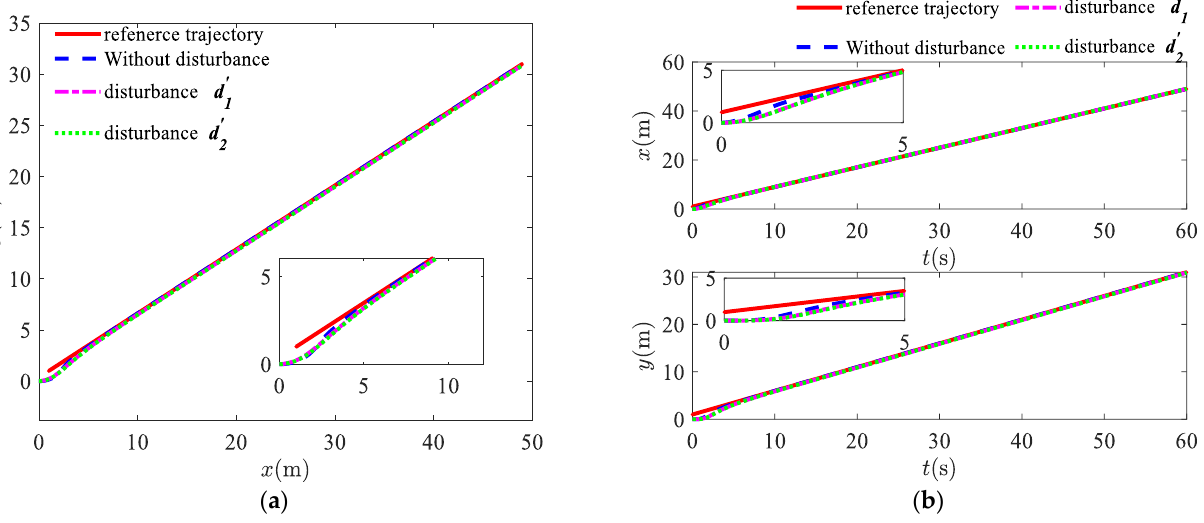
Figure 2. Straight-line trajectory tracking in three cases: ( a ) trajectory tracking in the xy plane; ( b ) trajectory tracking in the x -axis and the y -axis directions.